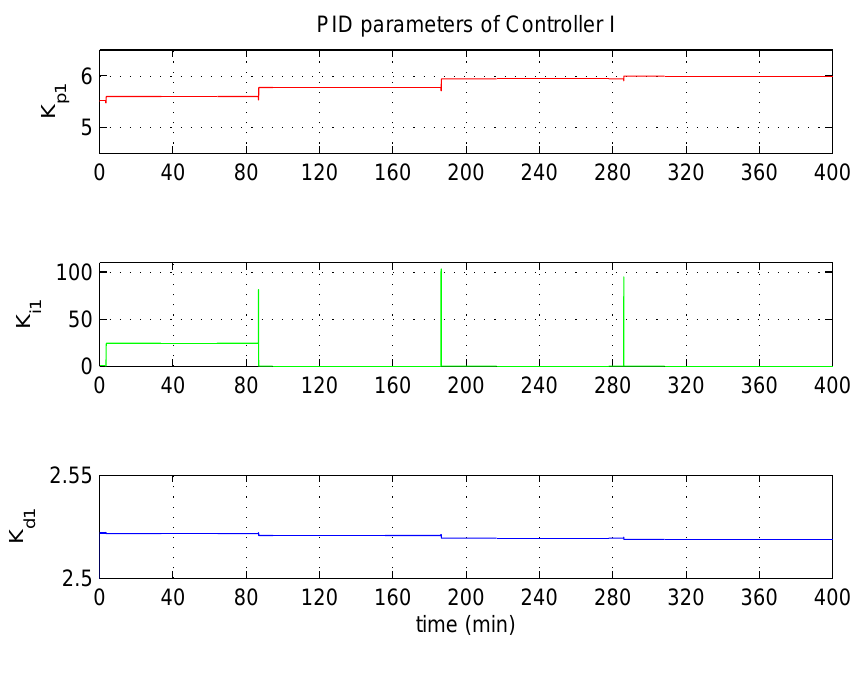
Figure 9. Variation of the PID parameters for Controller I during the tuning process.